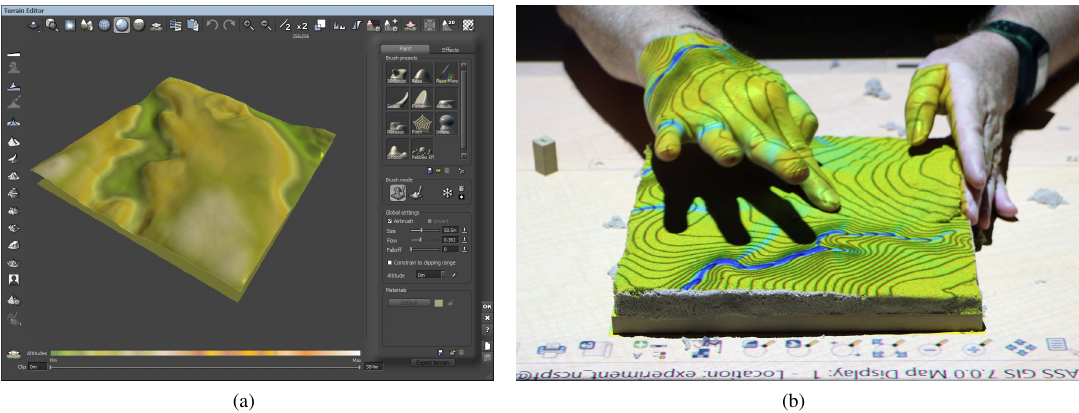
Figure 4: (a) Digitally sculpting with Vue in the 1 st exercise and (b) tangibly sculpting with Tangible Landscape in the 2 nd